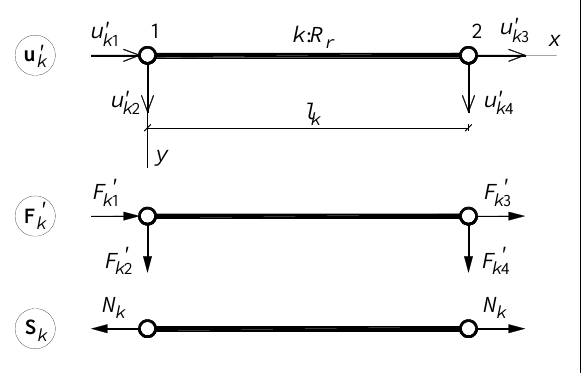
Fig. 2. Finite element LINK11 LINK11. It is an elastic-plastic equilibrium finite element of truss which can only lengthen or shorten (i.e. strains in axial direction are only evaluated) (Fig. 2). The vector of the internal forces of the element is S